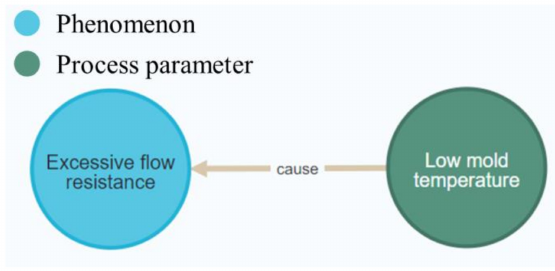
Figure 9. Picture of entity classification.